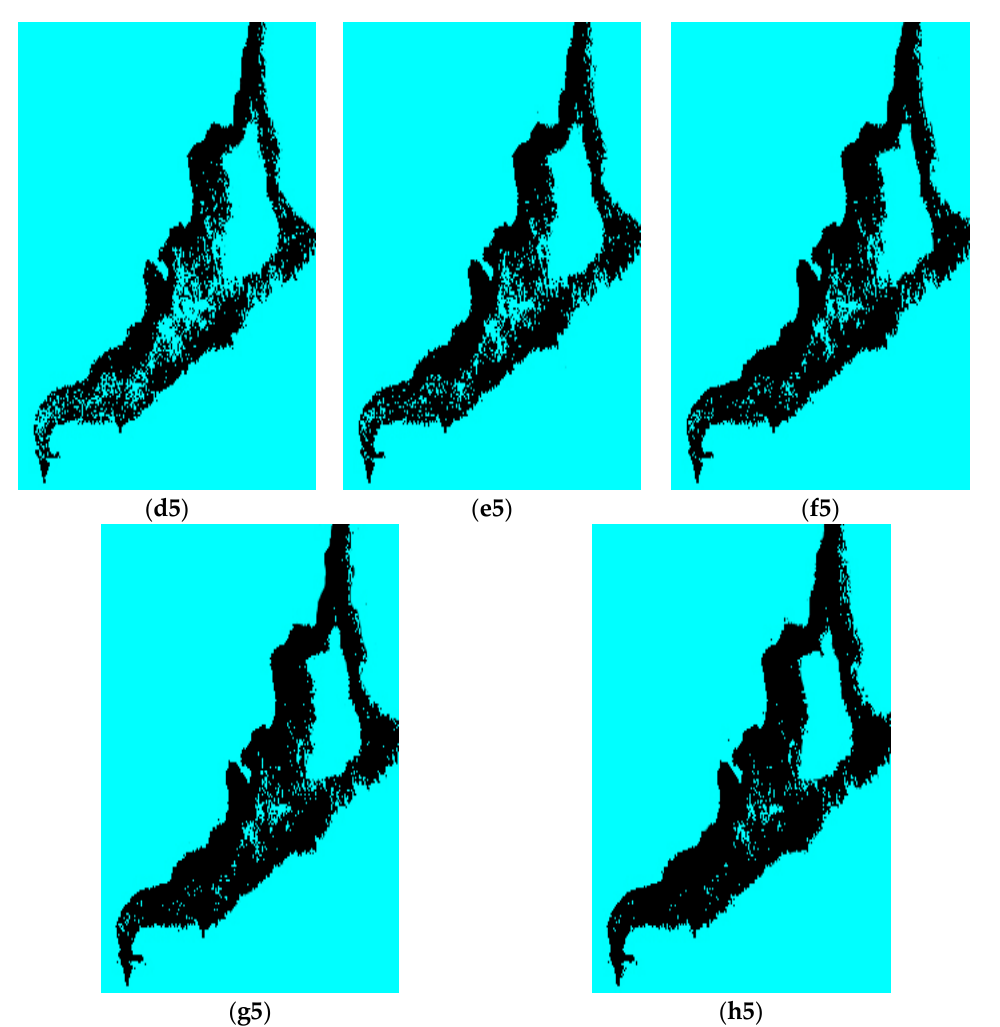
Figure 8. Images of the segmentation results obtained on our datasets. ( a1 , a2 , a3 , a4 , a5 ) SAR image, ( b1 , b2 , b3 , b4 , b5 ) label, ( c1 , c2 , c3 , c4 , c5 ) result of Resnet, ( d1 , d2 , d3 , d4 , d5 ) result of SegNet, ( e1 , e2 , e3 , e4 , e5 ) result of UNet, ( f1 , f2 , f3 , f4 , f5 ) result of DRNet, ( g1 , g2 , g3 , g4 , g5 ) result of SE-DRNet, and ( h1 , h2 , h3 , h4 , h5 ) result of ASA-DRNet. Light blue represents the sea, red represents the oil spill-like area, green represents land, and black represents the oil spill area.